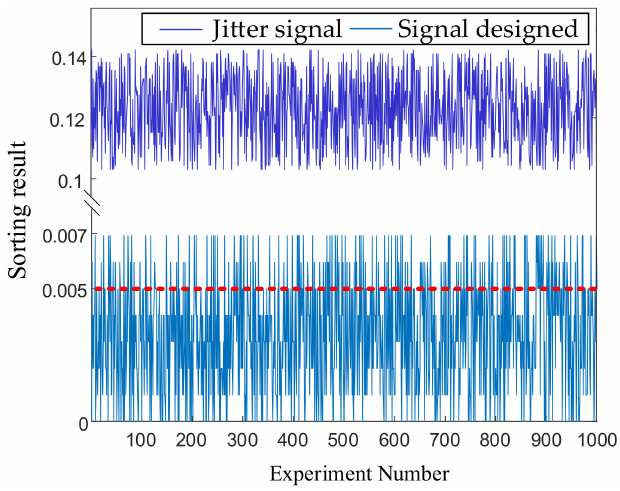
Figure 12. Comparison diagram of sorting